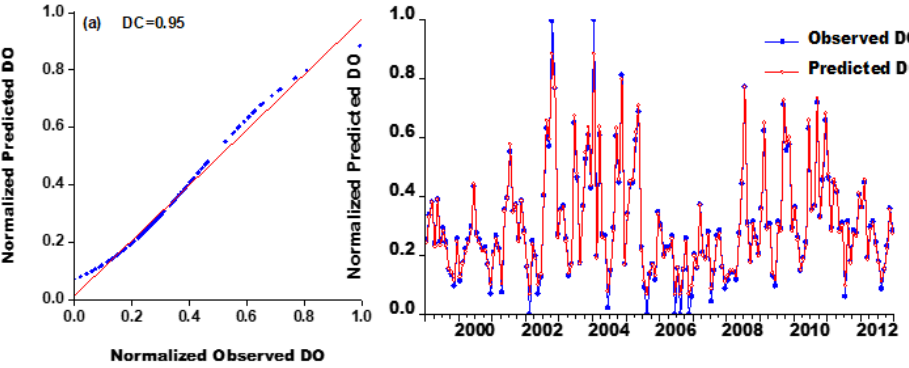
Fig. 5: Evaluation of FFNN model a) scatter plot (b) observe versus computed time series of DO